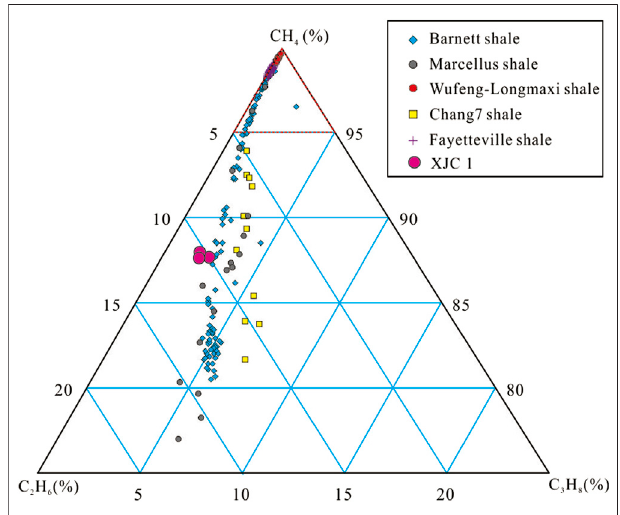
FIGURE 8 | Triangular diagram of CH 4 -C 2 H 6 -C 3 H 8 components of majorshalegasinChinaandtheUnitedStates(modi fi